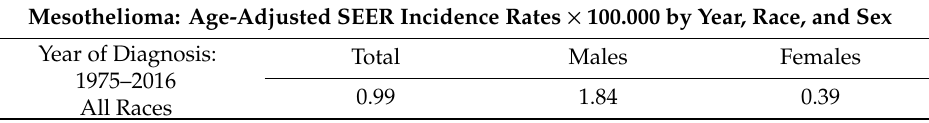
Table 2. Surveillance, Epidemiology, and End Results (SEER) 1975–2016 incidence rates by